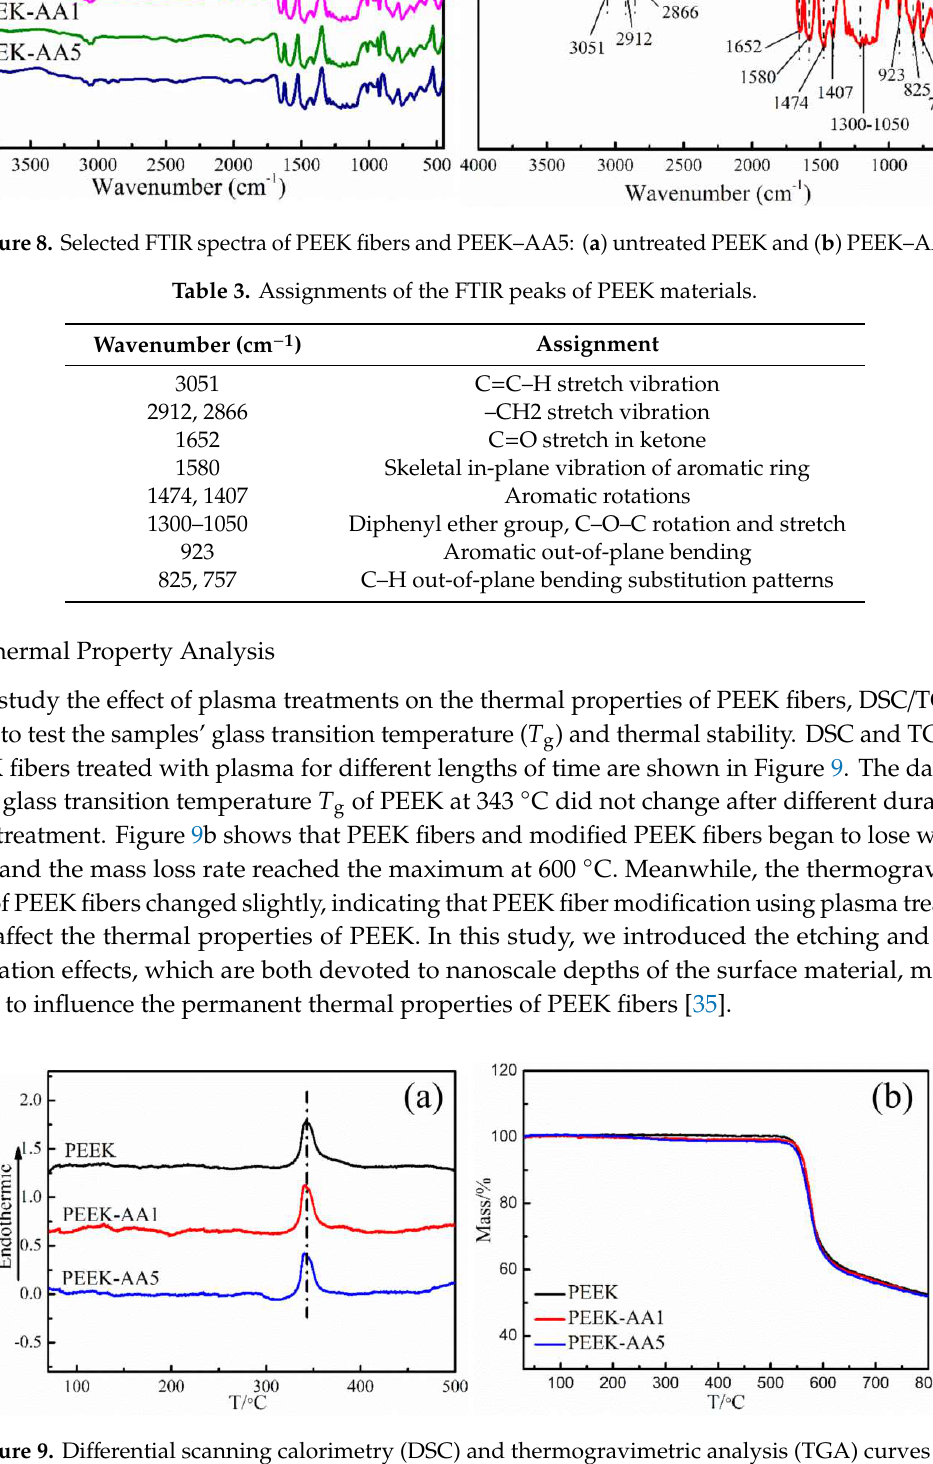
Figure 9. Differential scanning calorimetry (DSC) and thermogravimetric analysis (TGA) curves for PEEK fibers and plasma-treated PEEK fibers: ( a ) DSC curve and ( b ) TGA curve.